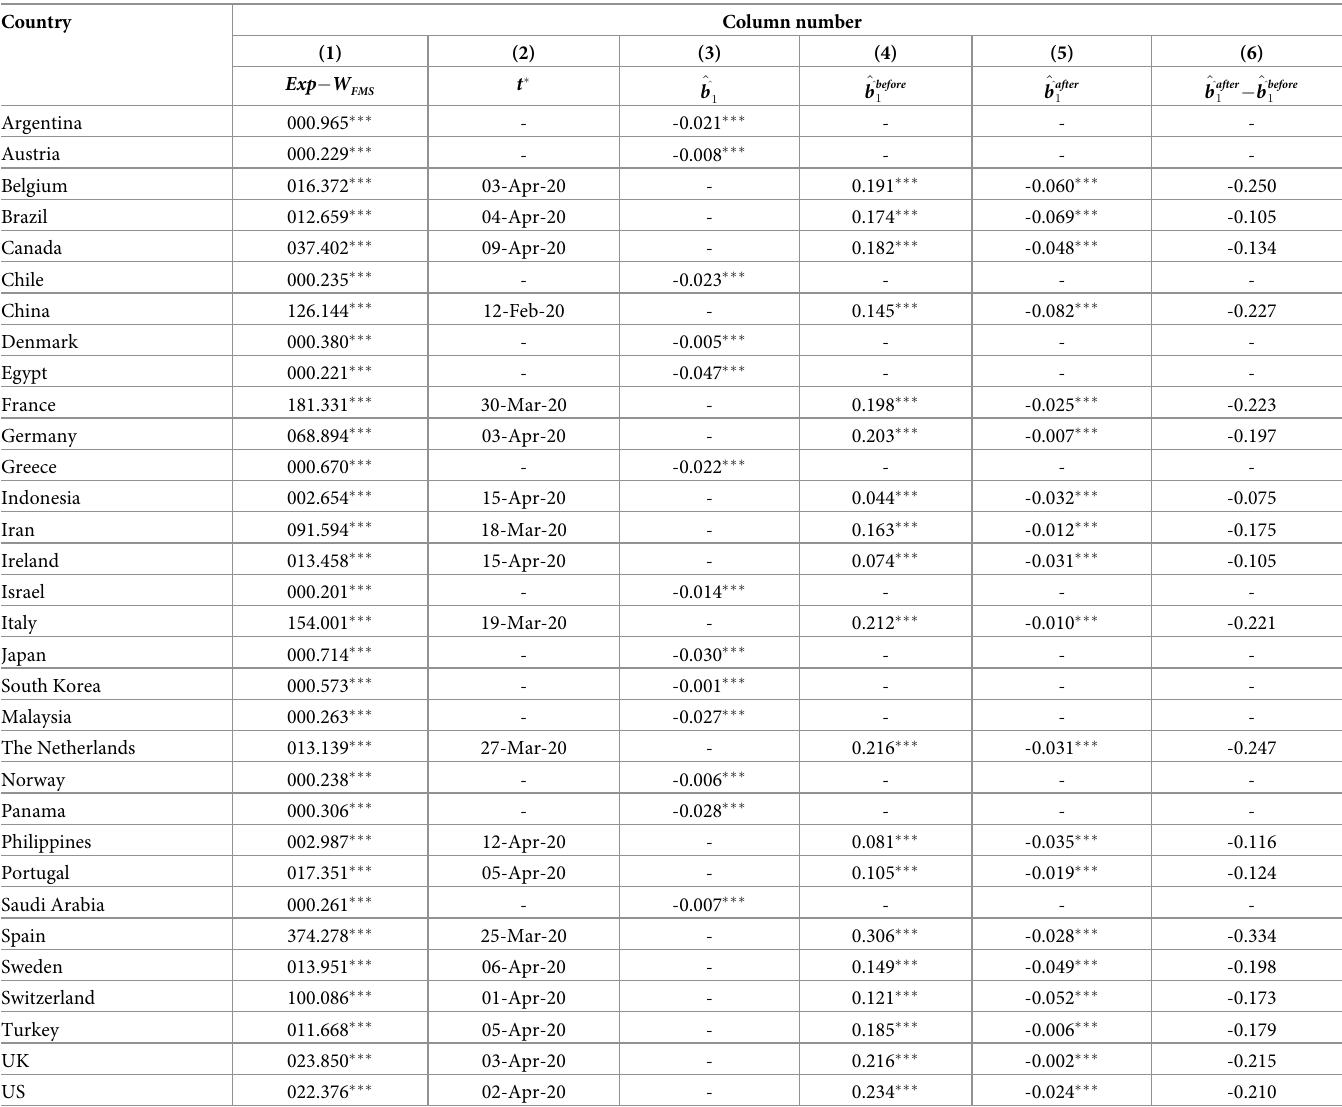
Table 1. Trend break test [10] and slope estimates